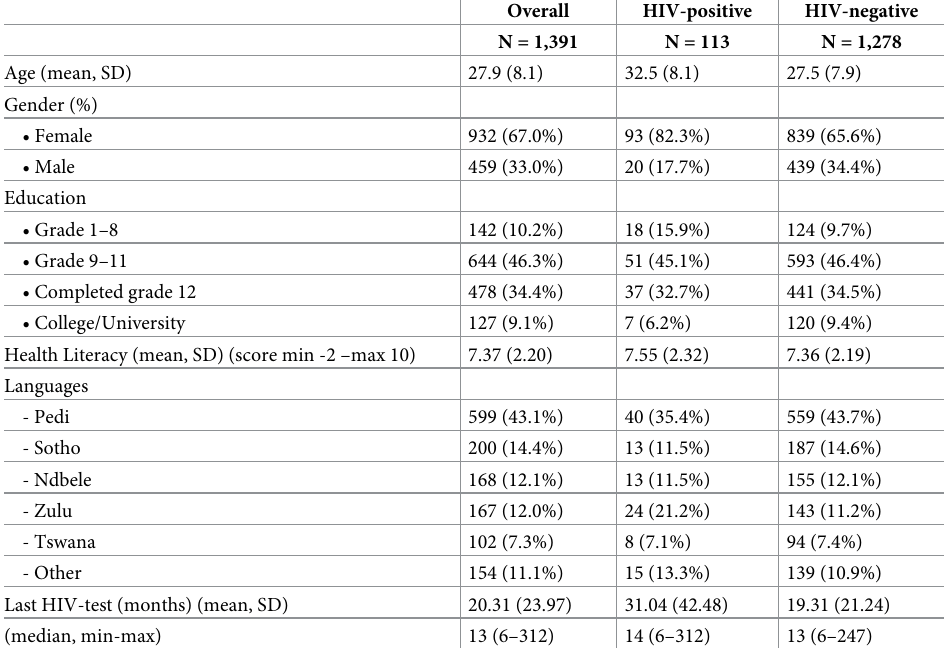
Table 1. Characteristics of study